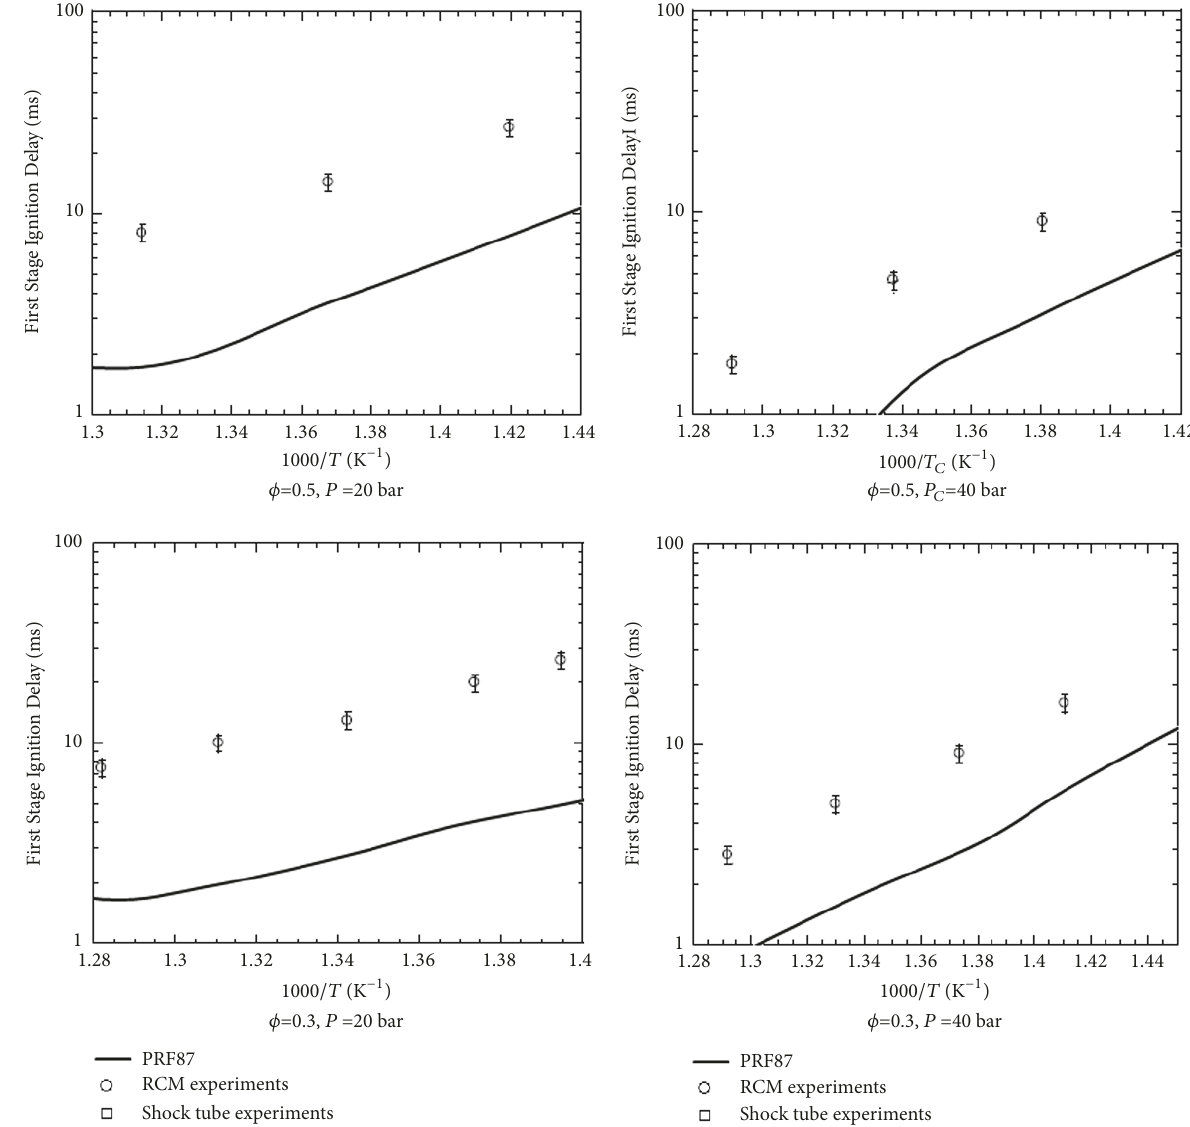
Figure 12: Comparison of experimental and simulated first-stage ignition delay times. Experimental data is from Kukkadapu et al. [23]. Surrogate simulations were carried out using the PRF87 surrogate and mechanism model of Samimi Abianeh et al.